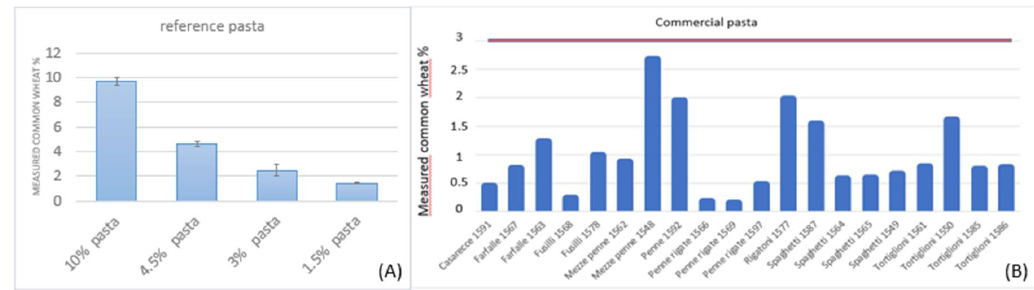
Figure 3. Common wheat percentages determined in 4 reference pasta ( A ) and in 20 commercial pasta samples ( B ) with duplex digital PCR (dPCR) assay. In (A) the percentages values before the word “pasta” indicate the common wheat contaminations. In (B) the red horizontal line indicates the maximum level of common wheat contamination allowed by law.)